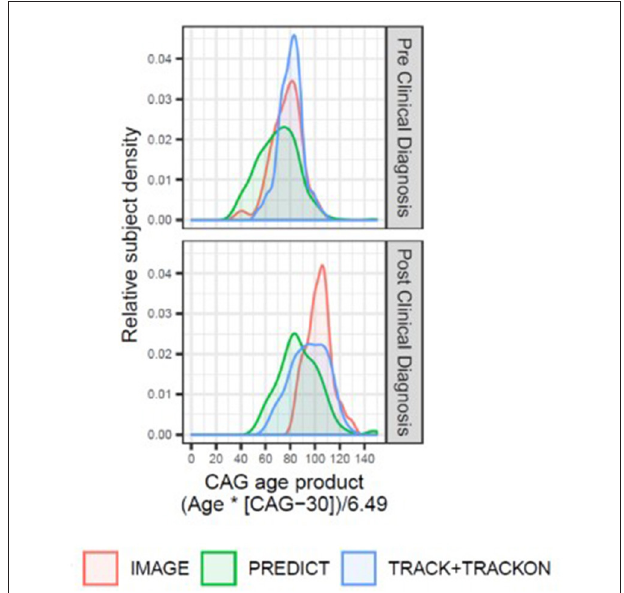
FIGURE 1 | Overview of the disease progression heterogeneity for imaging studies with publicly available datasets (IMAGE-HD, PREDICT-HD, and TRACK-HD/Track-On HD) displaying the relative proportion of participants within each study ( y -axis) by participant CAP score ( x -axis). A single CAP score was computed for each participant using the age at enrollment in that study. The density plots are colored by study and separated by HD clinical diagnosis status (upper panel: individuals with expanded CAG repeats before clinical motor diagnosis; lower panel: individuals with HD clinical motor diagnosis). The TRACK-HD and Track-On HD had overlapping populations, and study sites, and were